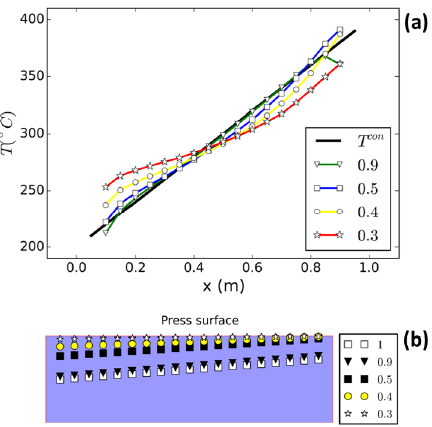
Fig. 12. Comparison between temperature pro fi les (a) and the corresponding heat sources positions (b) for several energy consumption Table 3. Variation of temperature difference D T between obtained and target temperature with respect to energy consumption.